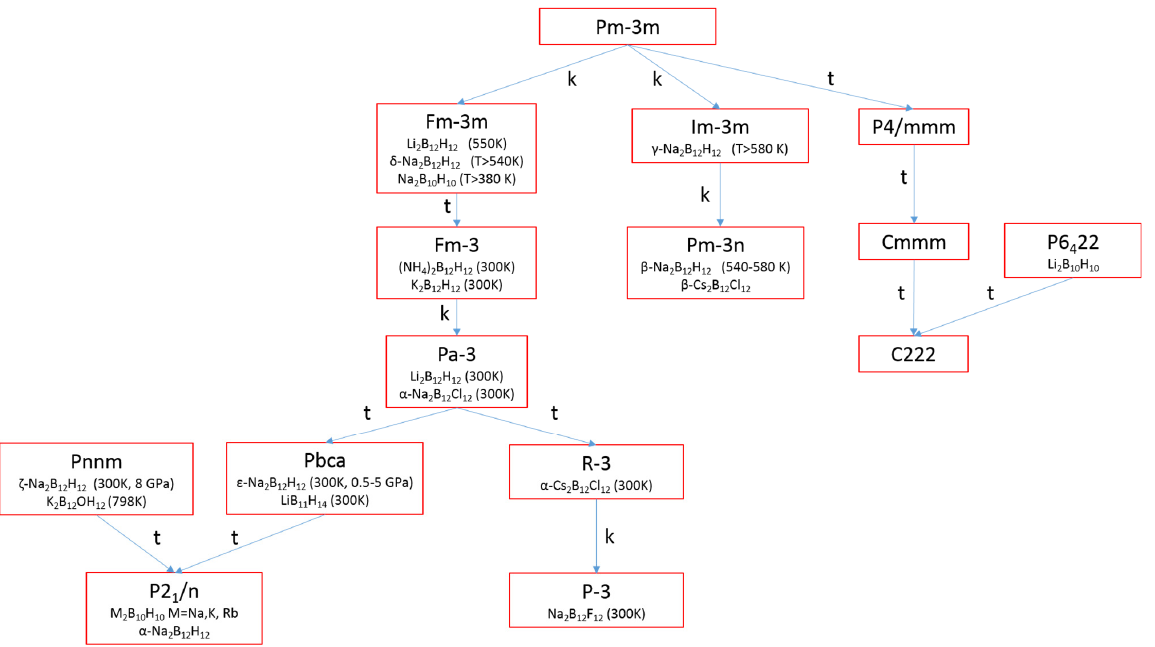
Figure 3. Group–subgroup relationships between space groups (in Herrmann ‐ Mauguin notation) of closo ‐ hydro borates and some closo ‐ halogeno borates. t, “translationengleich” subgroups; k, “klassengleich” subgroups. Table 1. Examples of ionic conductivity in mixed borate